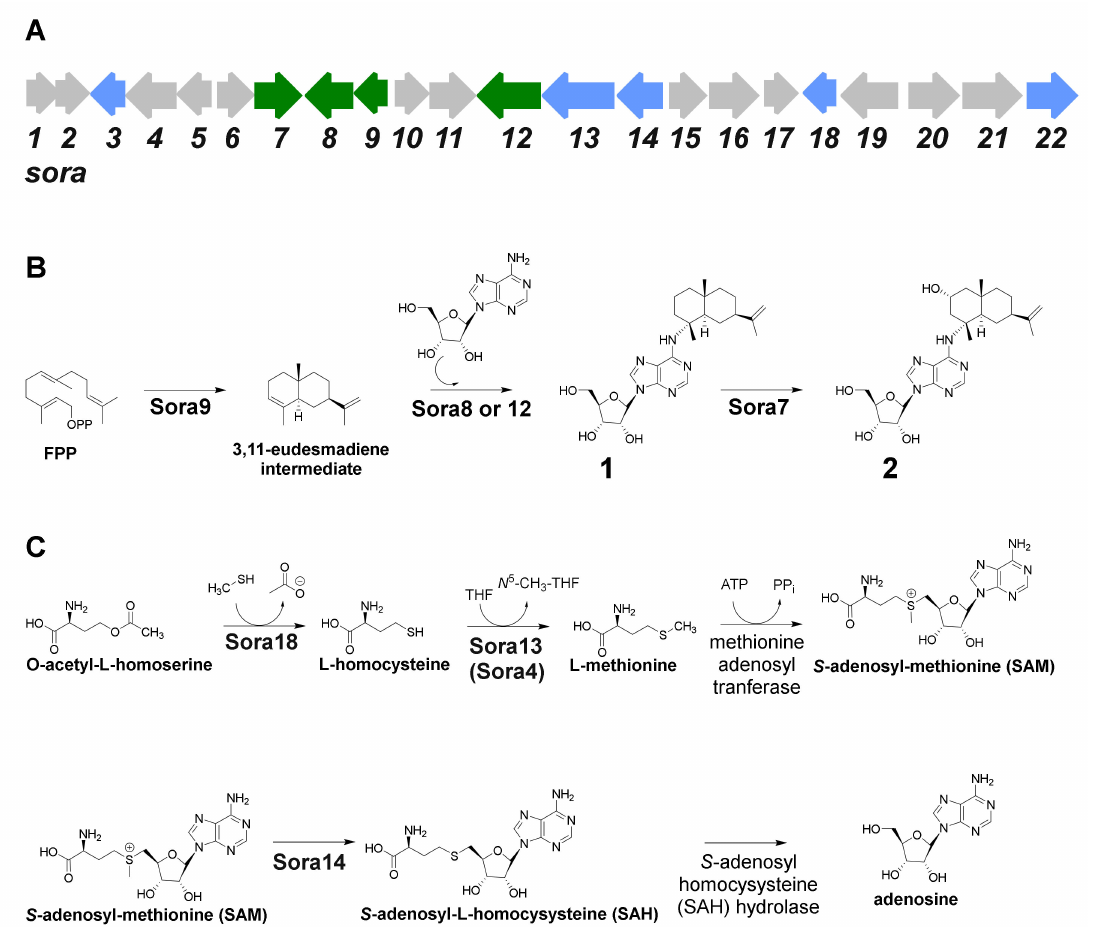
Figure 5. ( A ) Genetic organization of the candidate biosynthetic gene cluster responsible for the biosynthesis of sorangiadenosine ( 1 ) and 2-hydroxysorangiadenosine ( 2 ). ( B ) Proposed biosynthetic route leading to 1 and 2 . ( C ) Catalyzed reactions to increase the supply of